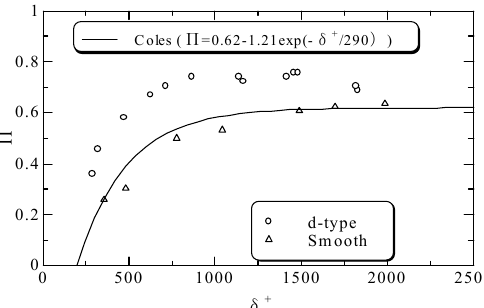
Fig.8 Developments of the wake parameter and comparison with the smooth wall